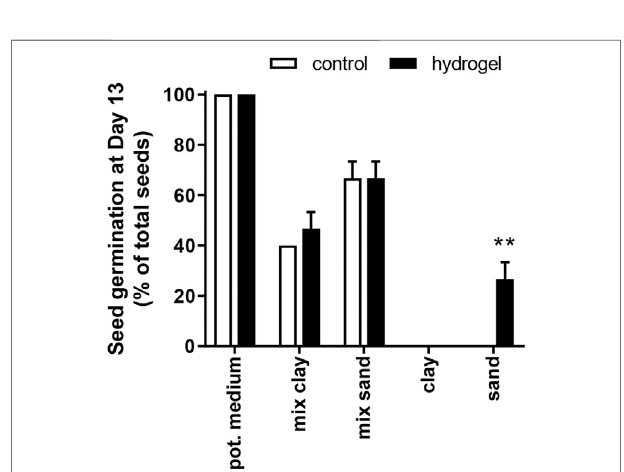
FIGURE 3 | Percentage of seed germination of radish ( Raphanus sativus ) after 13 days. For each condition, fi ve seeds were positioned per pot, fi lled with potting medium, or soils from MDRS location (see Table 1 ) supplemented with 10% (w/w) potting medium, or soils alone, respectively, with (hydrogel) or without (control) 0.1% (w/w) hydrogel supplementation. Data are means of three replications. Statistical analysis for comparison between control and hydrogel conditions: unpaired Student ’ s t-test. ** p < 0.01.